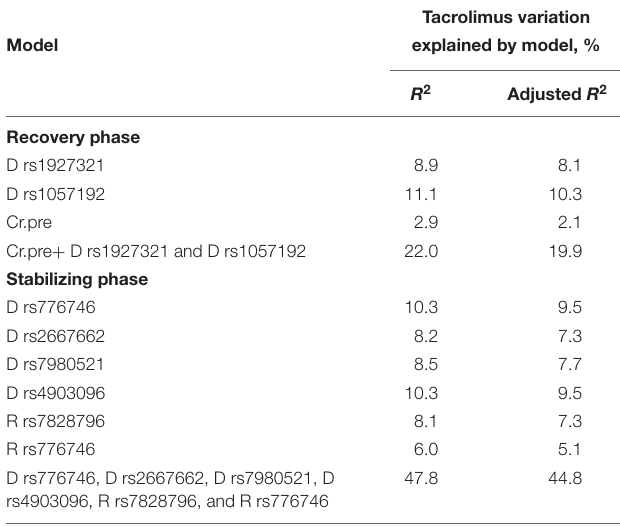
TABLE 4 | Tacrolimus variance in natural log–transformed dose-normalized tacrolimus troughs explained by a model in recovery phase and stabilizing phase